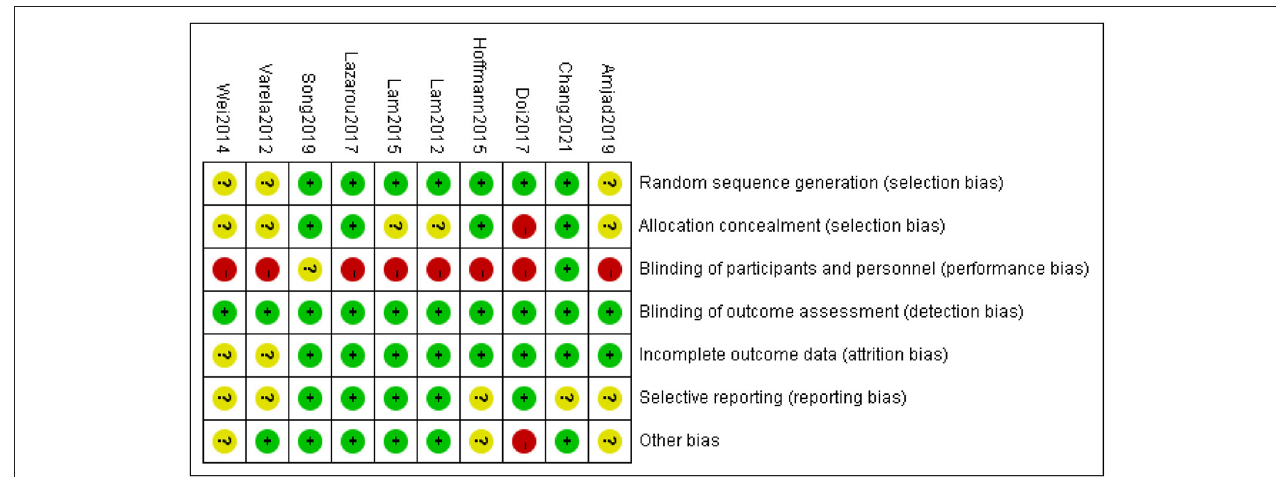
FIGURE 2 | Risk of bias summary of inclusion